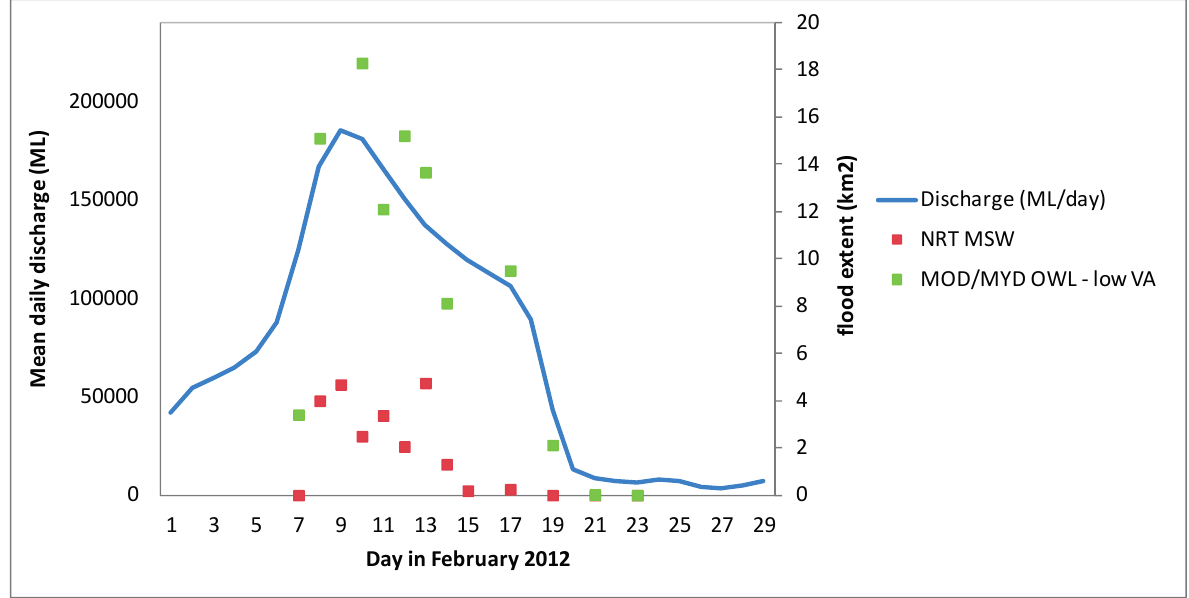
Figure 11. MODIS flood extent from the MODIS OWL and the NASA generated NRT MODIS Surface Water (MSW) product for Site W1 for February 2012. The MODIS OWL flood extent uses only those pixels mapping at least 6% inundation and a range distance of less than 1000 km (low View Angle) for the MOD and MYD data. Streamflow is also